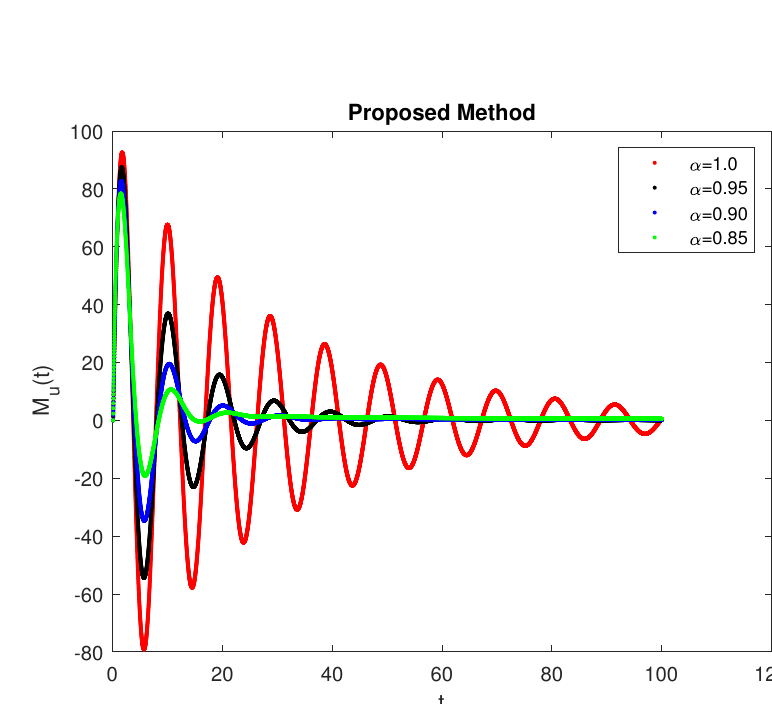
Figure 16: Numerical simulations for τ = 0.98 for Caputo